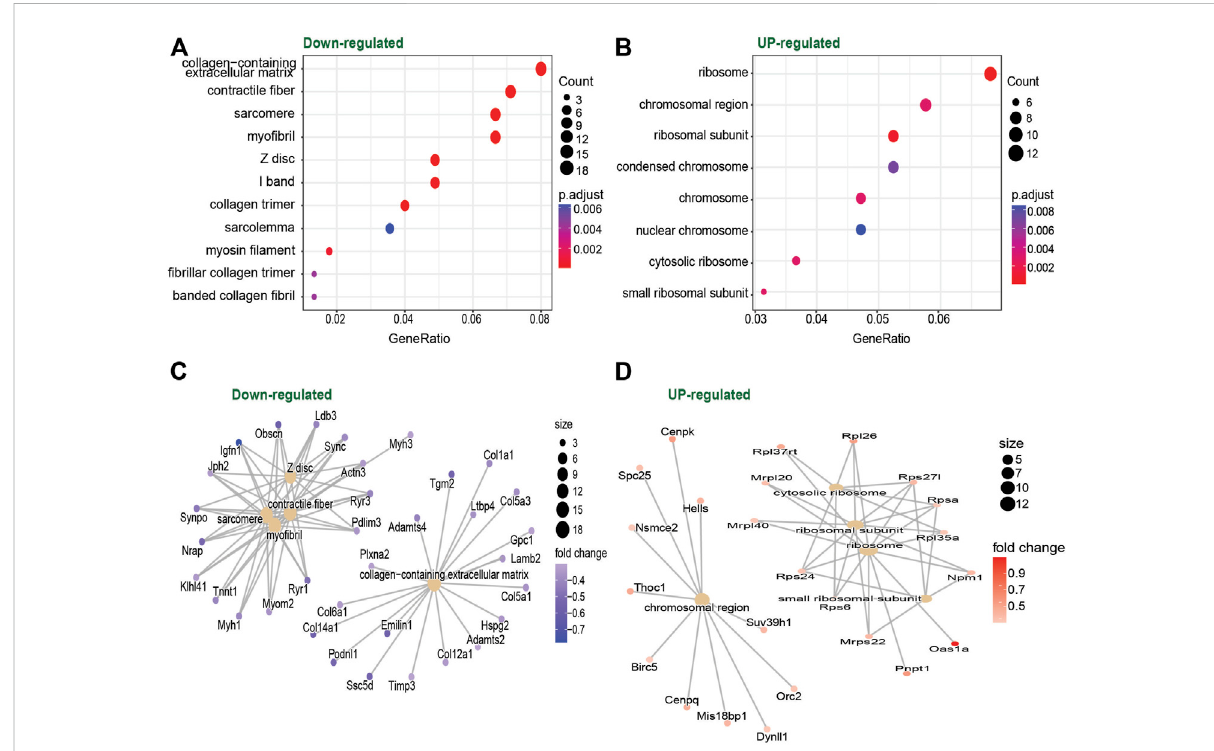
FIGURE 3 Dot plot of gene ontology enrichment of Down-regulated (A) and Upregulated (B) genes in C2C12 cells culture with vs. without miR-486. Red indicates higher enrichment; blue indicates lower enrichment. The sizes of the dots represent the gene counts of each row (GO category). Enrichment map of the inter-relation of the top 5 enriched biological processes on the Downregulated (C) and Upregulated (D)